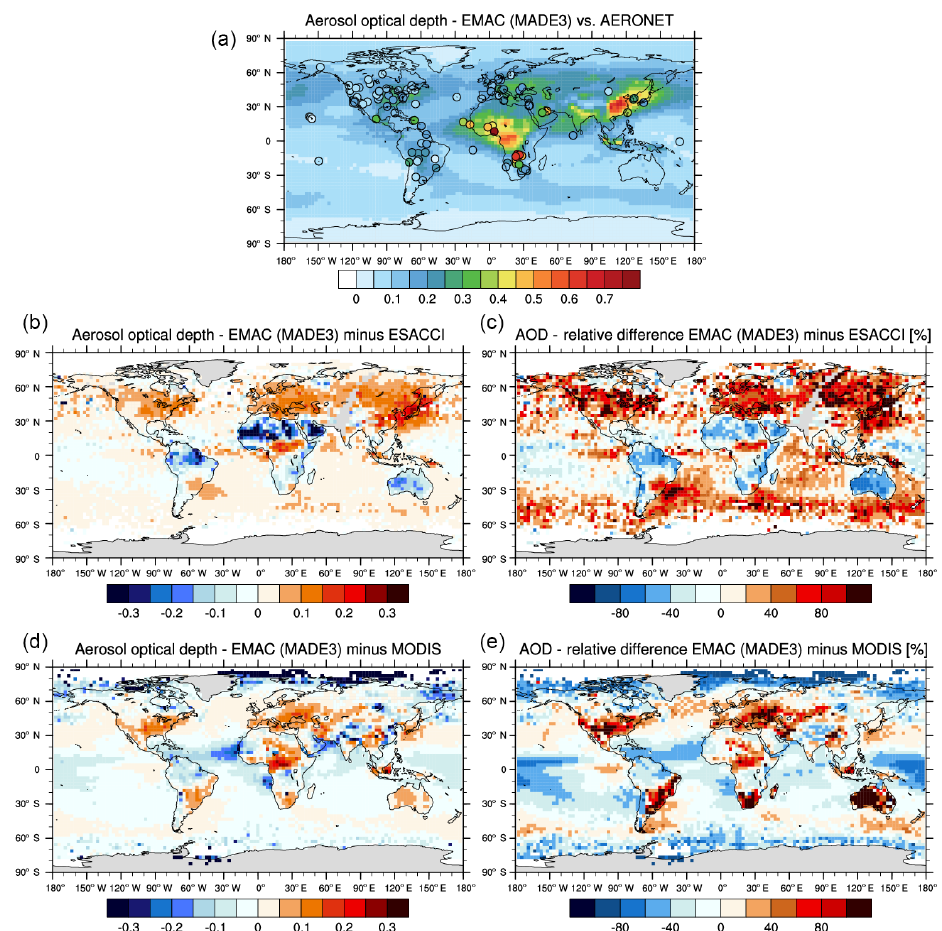
Figure 10. Annual mean AOD in the reference simulation with MADE3 ( a , background color) vs. observations from the AERONET network ( a , filled circles) and vs. satellite data from the ESACCI Swansea University (SU) ATSR-2 v4.21 aerosol product (b, c) and from MODIS Level 3 Collection 6 (d, e) . The comparison against satellite data is shown as both absolute (b, d) and relative (c, e) difference. “Pixels” in the panels correspond to the model grid. Results are shown for the year 2000 (AERONET and ESACCI) and for 2003